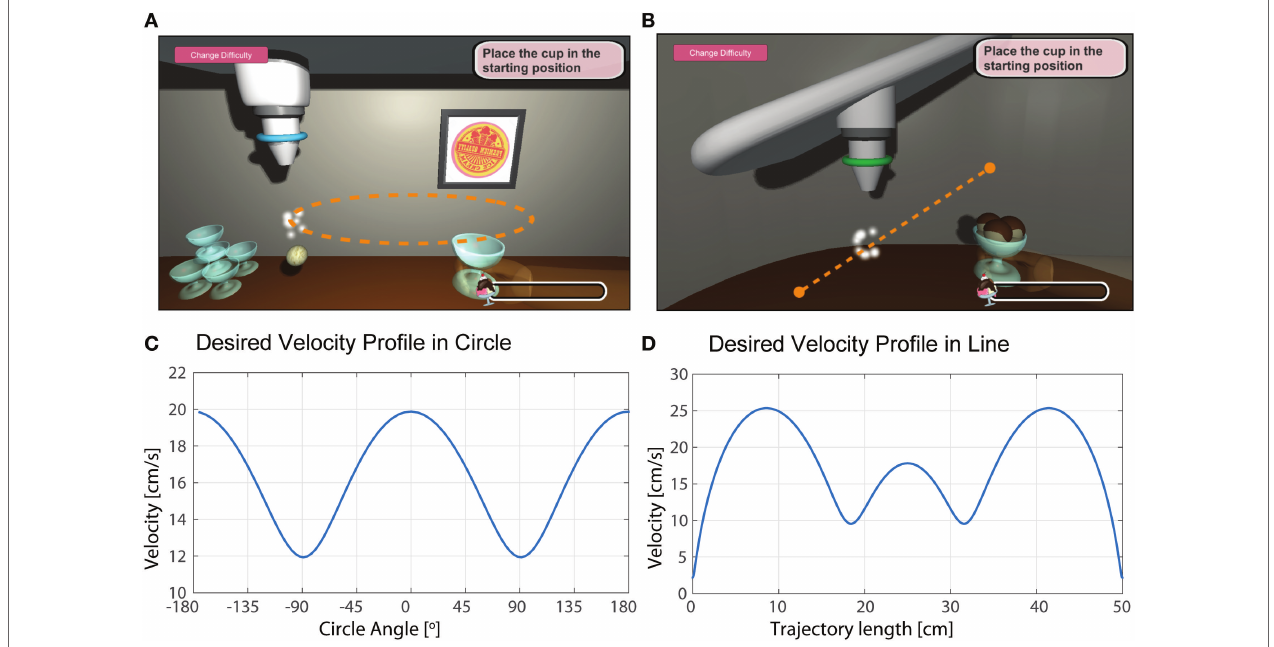
FIGURE 5 | (A) Screen shot of the ice cream dispenser (circle). (B) Screen shot of the toppings dispenser (line). (C) Desired speed profile in the circle task. (D) Desired speed profile in the line task. The dashed lines were not displayed to subjects.